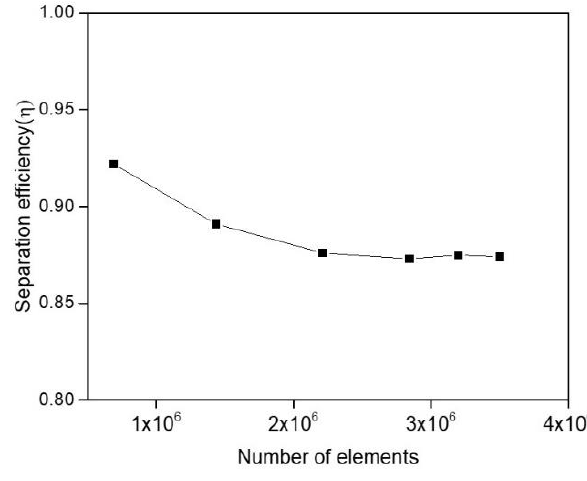
Figure 4. Grid dependency test.